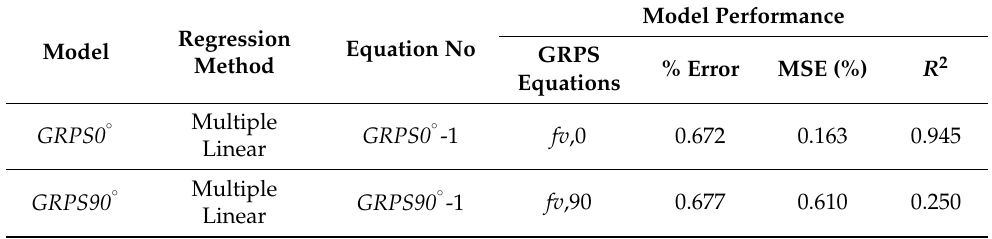
Table 7. Correlation Coefficients for Parallel and Perpendicular to the Grain Directions.